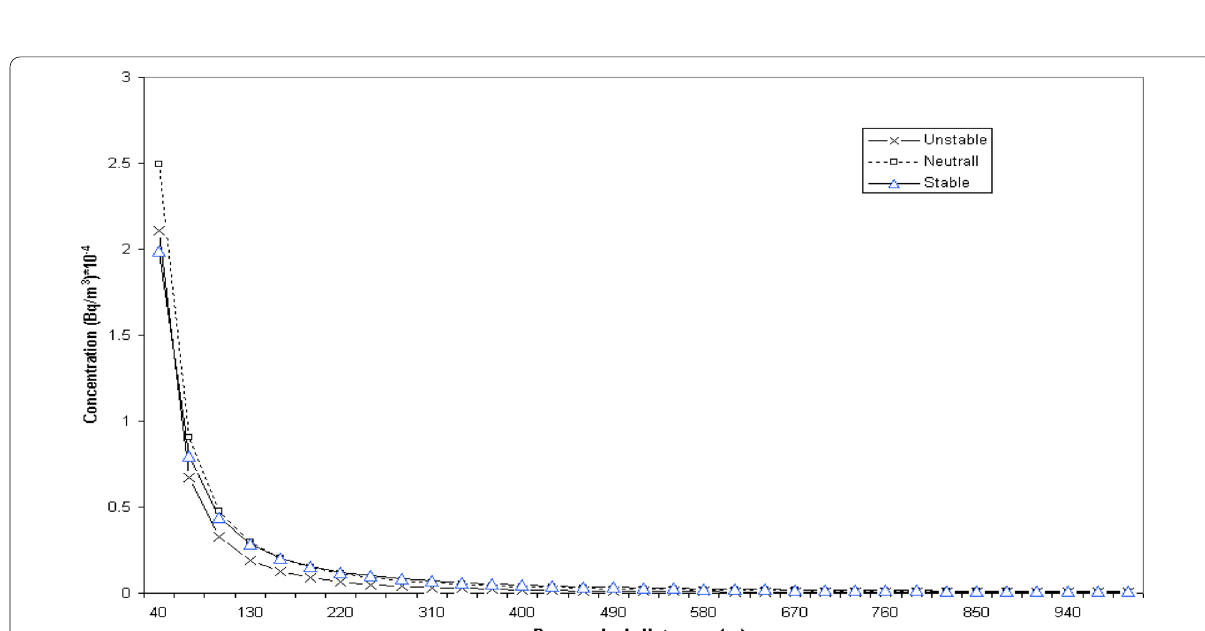
Fig. 9 The concentration for Cs 137 via downwind distance when H is a constant